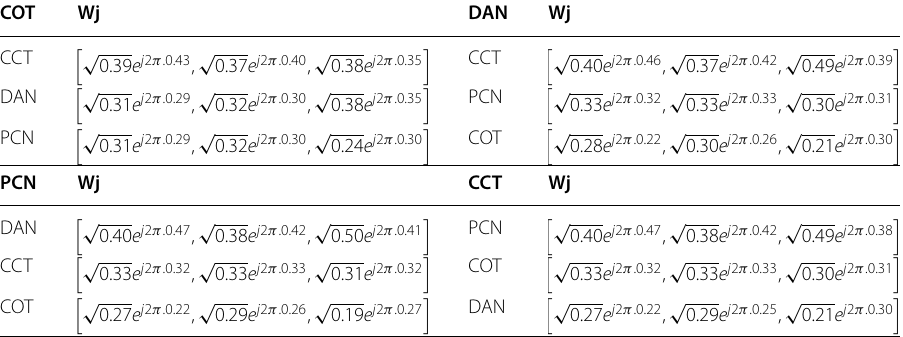
Table 5 wj values of quantum spherical fuzzy sets COT Wj DAN Wj CCT